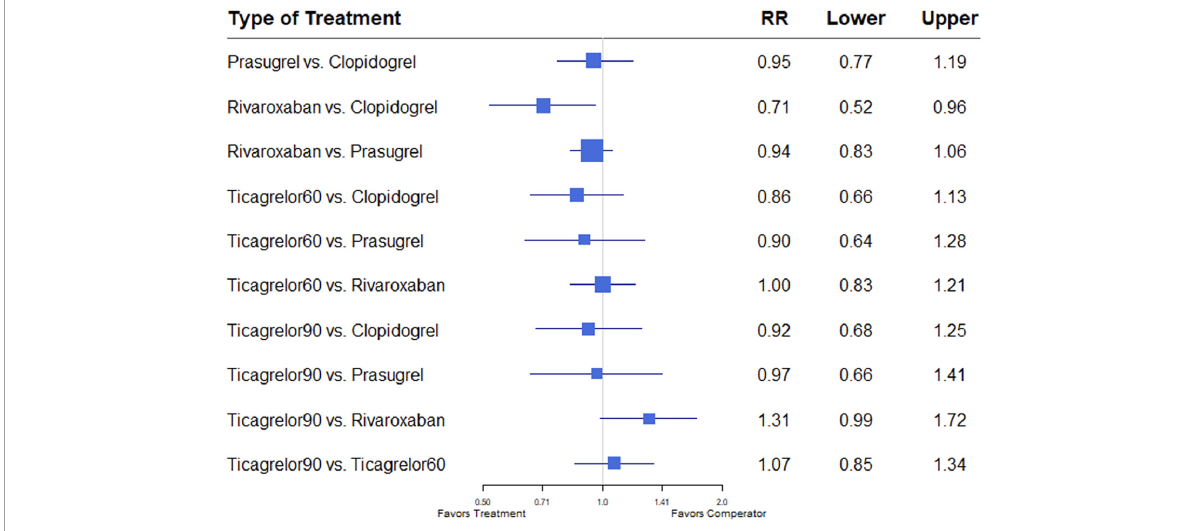
FIGURE2 A network meta-analysis of the association between anti-thrombotic therapy and mortality in patients with chronic coronary syndrome. Net-work Meta-analysis of the Association Between anti-thrombotic therapy and mortality. The size of squares is proportional to the weight of each study. Horizontal lines indicate the 95% CI of each treatment; diamond, the pooled estimate with 95% CI; and RR, relative